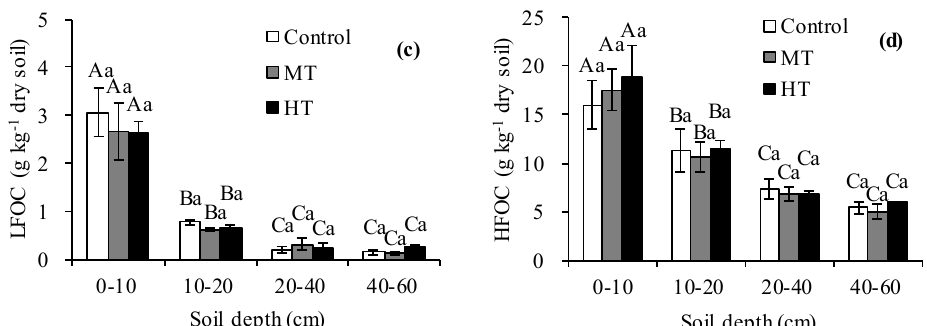
Figure 1. Concentrations of ( a ) soil organic carbon (SOC), ( b ) dissolved organic carbon (DOC), ( c ) light fraction organic carbon (LFOC), and ( d ) heavy fraction organic carbon (HFOC) under the three treatments, at different soil depths. Different lowercase letters denote a significant difference between the treatments at the same soil layer ( p < 0.05), different capital letters to describe differences between soil depths ( p < 0.05); Control—traditional management model, MT—moderate thinning, and HT—heavy thinning; n = 3, mean ± SD.